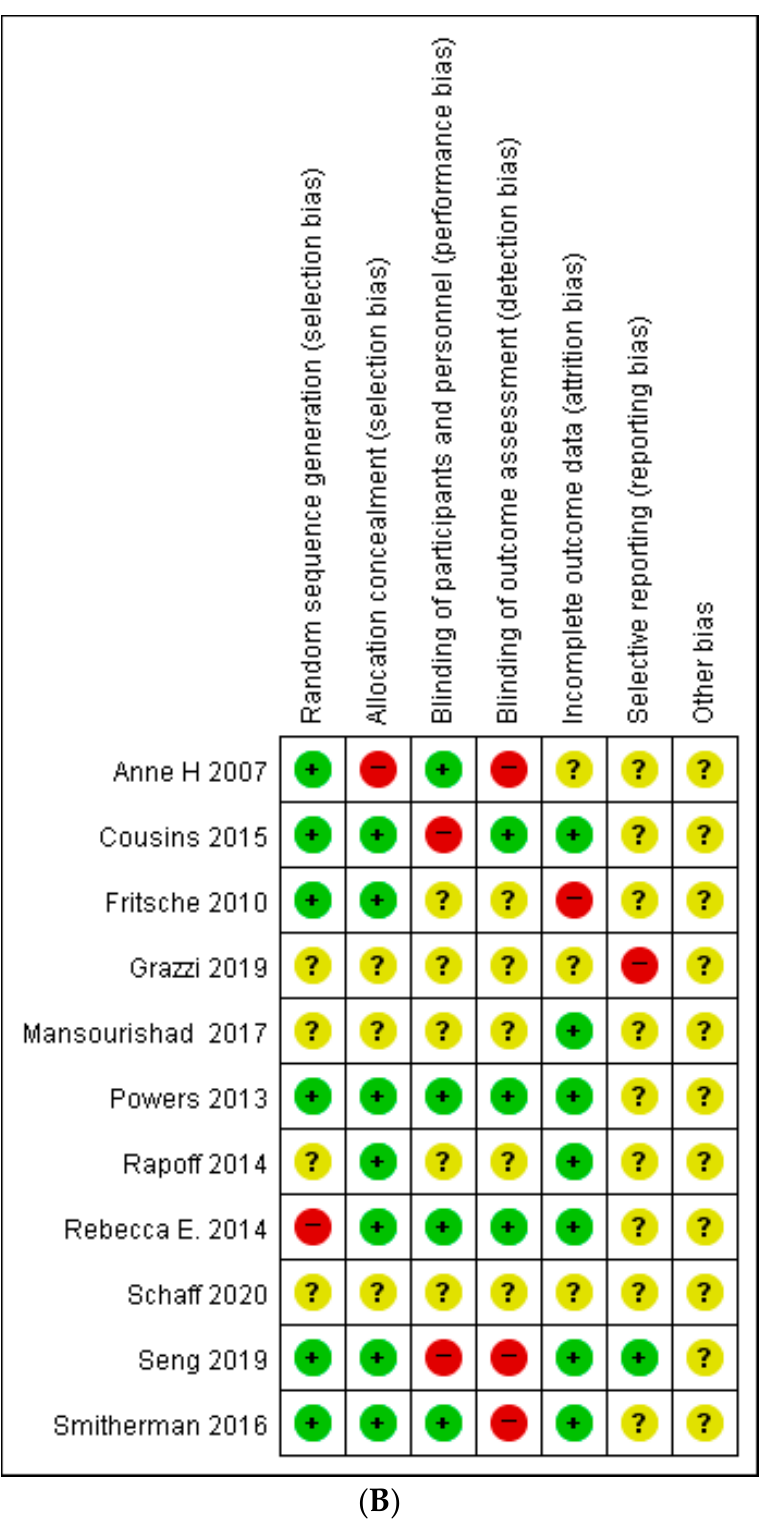
Figure 2. Assessment of risk of bias. ( A ): Risk of bias graph . ( B ): Risk of bias summary .